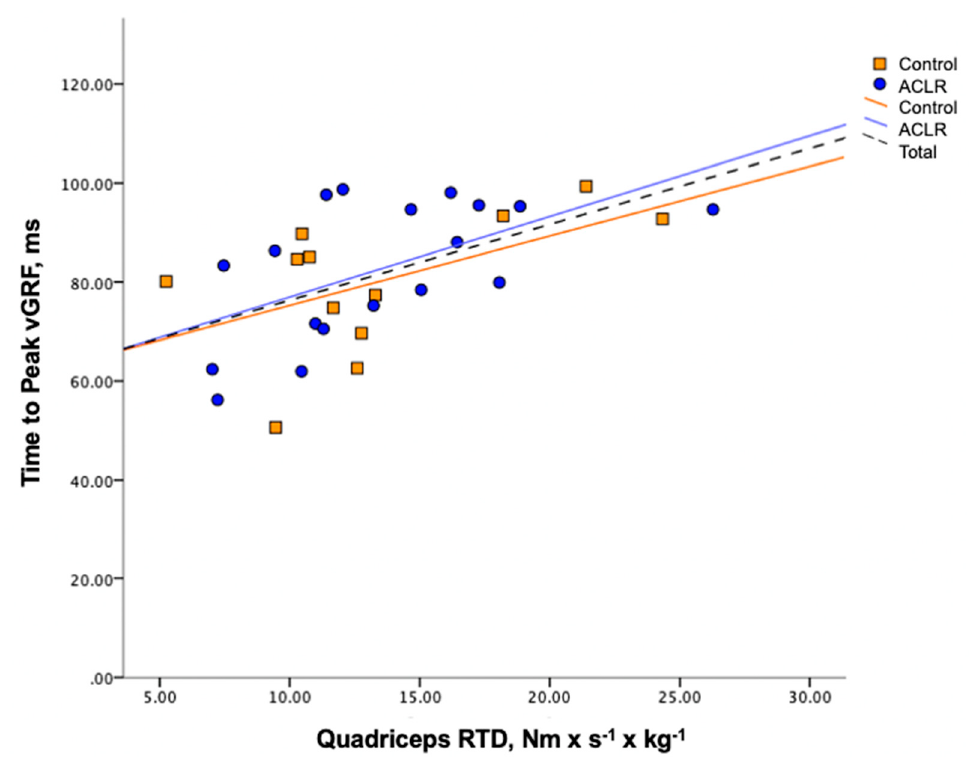
Figure 2. Group scatter and regression lines of time to peak vertical ground reaction force (vGRF) by quadriceps rate of torque development (RTD) during single-leg jump cut.